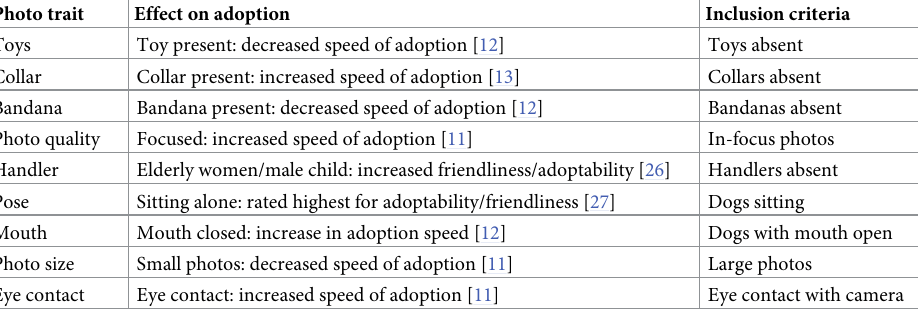
Table 2. Inclusion criteria for mutable photo traits of